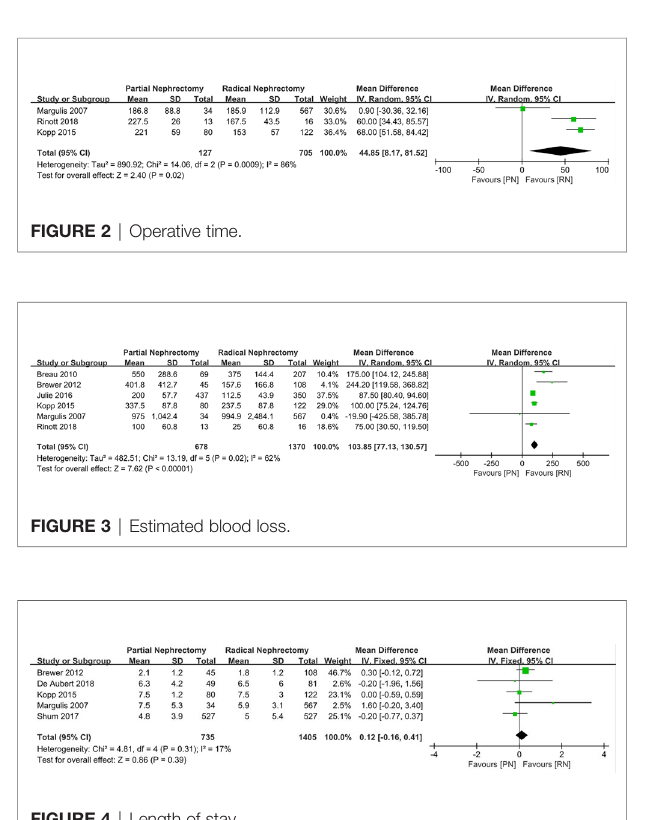
FIGURE 4 | Length of stay.